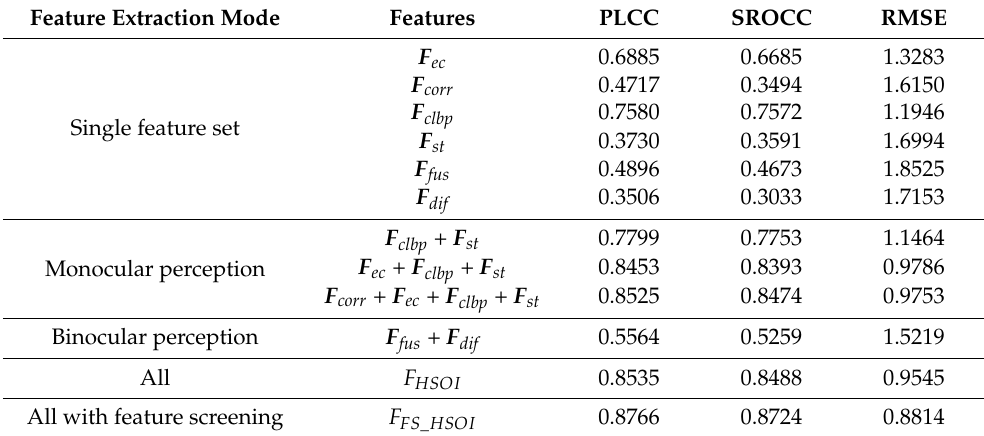
Table 7. Performance of different feature sets and their